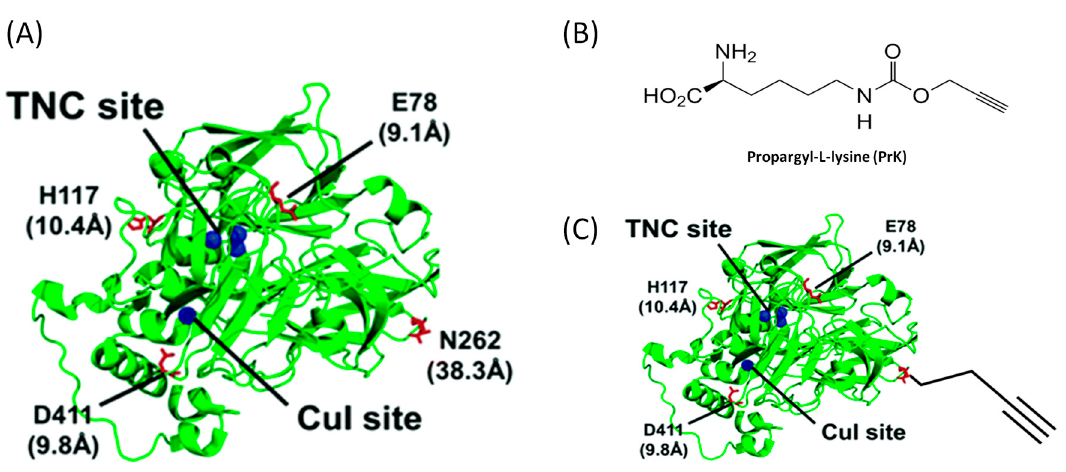
Figure 6. ( A ) 3D structure of cuprous oxidase (CueO) including the two redox centers (blue spheres). The four noncanonical amino acids (nCAAs) incorporation sites are labeled in red; ( B ) Chemical structure of Propargyl-L-lysine (PrK); ( C ) Genetically modified enzyme offering a unique alkyne moiety for site-specific attachment to electrodes via click chemistry [134].